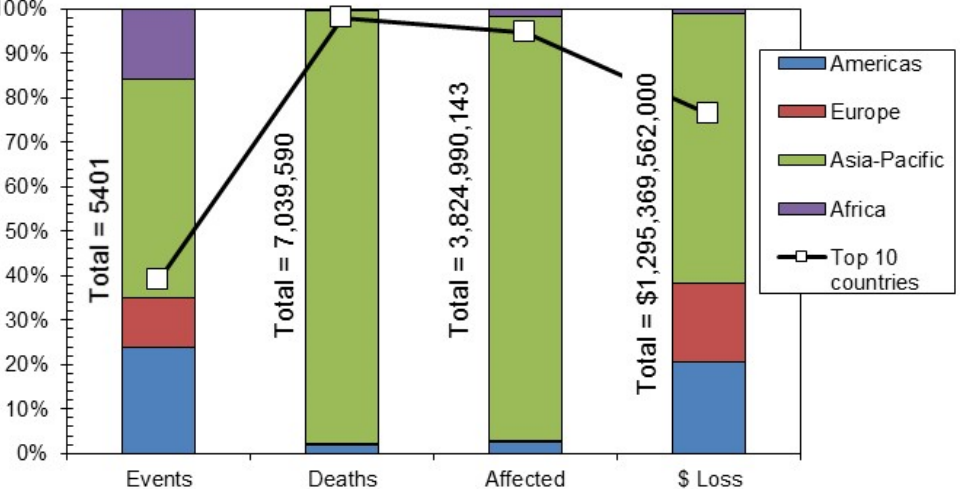
Figure 4. Distribution of events, deaths, persons affected, and economic loss due to hydrological disasters across the globe during the period 1900–2020 AD (Source: